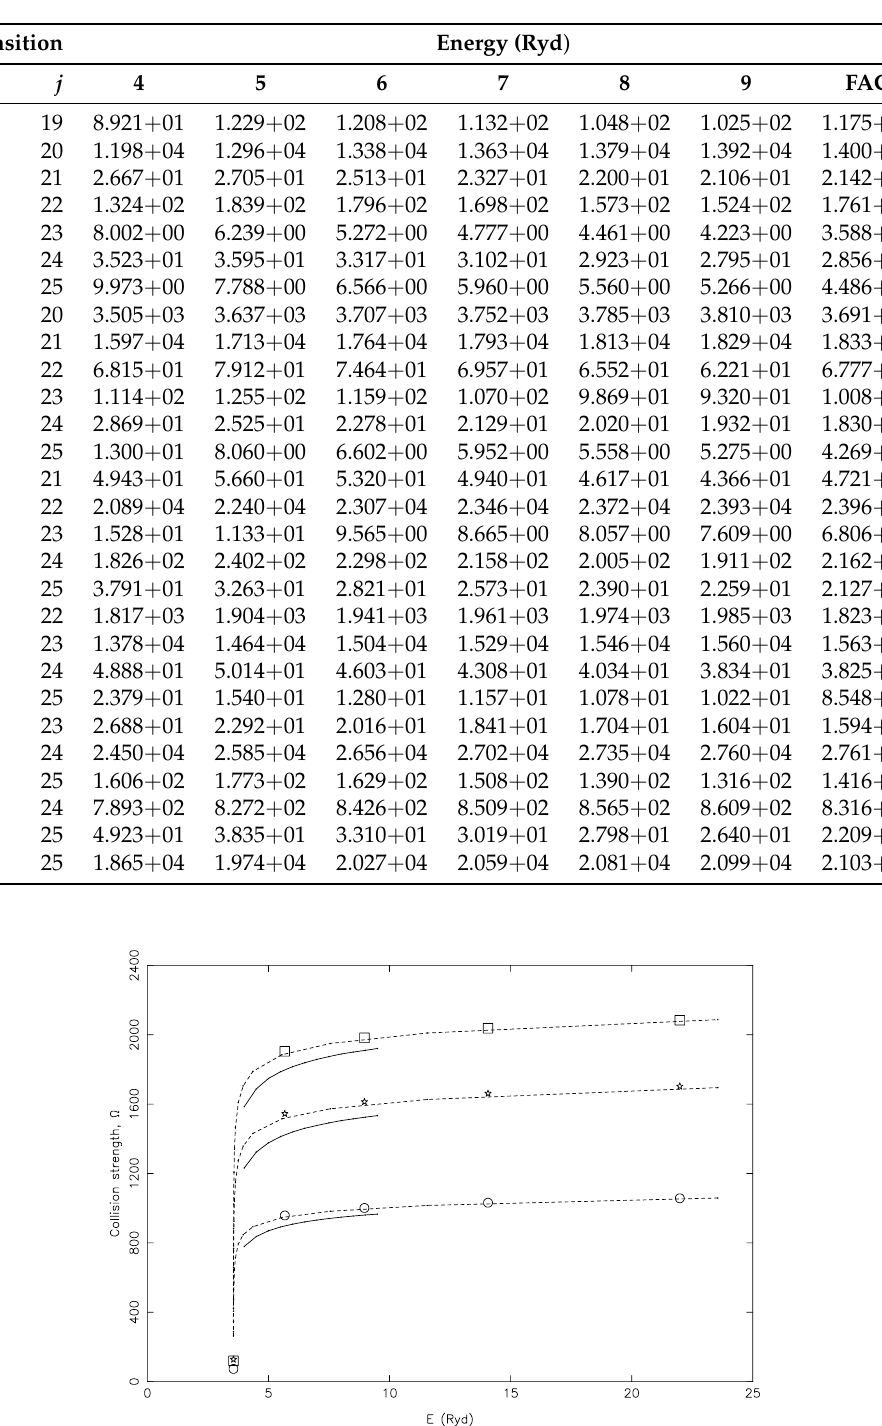
Figure 4. Comparison of collision strengths for the 5–7 (3p 2 P o and 8–9 (3p 2 P o –3d 2 D 5/2 ) transitions of He II. Continuous curves are from our calculations from 3/2 DARC , broken curves are from the CC+CB programs, and the Ω from FAC are shown as, circles: 5–7, stars: 6–8 and squares: 8–9